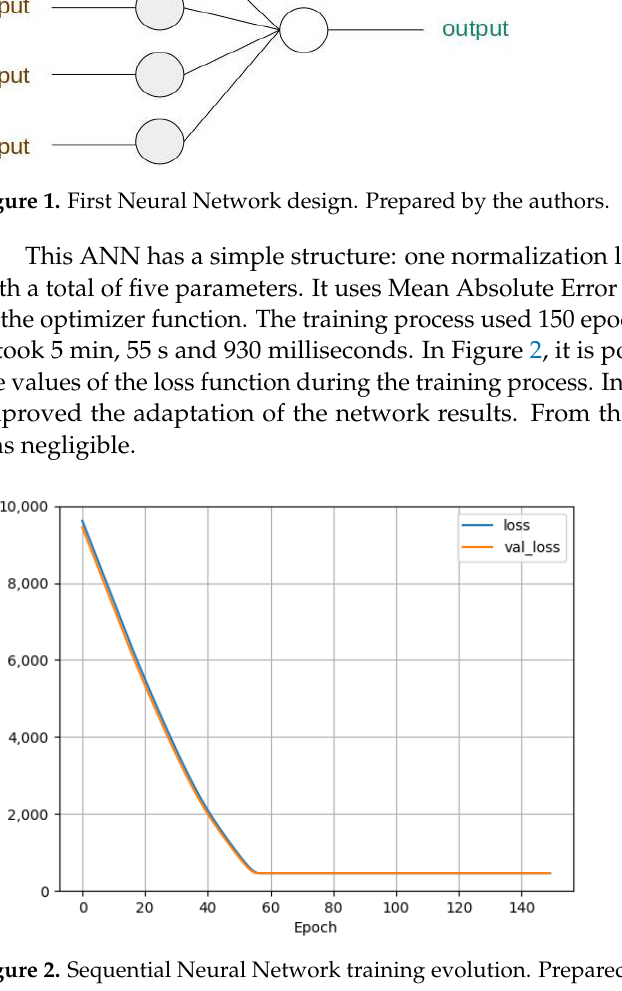
Figure 2. Sequential Neural Network training evolution. Prepared by the authors.